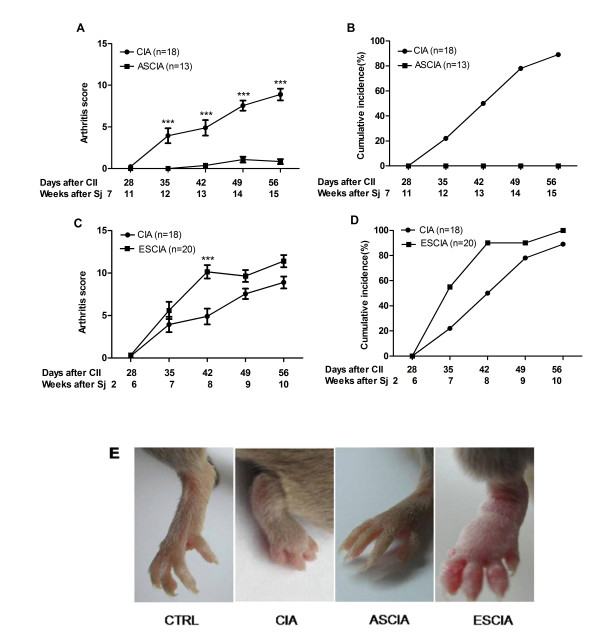
The protective effects against arthritis were only observed when a pre-established Sj infection entered acute stage. DBA/1 mice were infected with Sj for 2 weeks or 7 weeks prior to immunization with collagen II (CII) in CFA and named as ESCIA mice and ASCIA mice respectively. 7 weeks Sj infection significantly reduced the severity (A), incidence (B) and clinical signs (E) of arthritis in ASCIA mice; whereas 2 weeks infection by Sj failed to decrease the severity (C), incidence (D) and clinical signs (E) of arthritis in ESCIA mice. Arthritis was scored weekly as described in Materials and Methods. Circle and square represented uninfected CIA mice and Sj infected CIA mice respectively. CIA data represented the combined results from two different age groups from multiple experiments due to their similar severity and incidence. Data in ESCIA mice were the means and the standard errors of the mean (SEM) of clinical scores from 20 individual mice combined from two separate experiments, while data in ASCIA mice were from 13 individual mice combined from three separate experiments. Significance was tested by two way ANOVA with Bonferroni multiple comparison test with *** as p < 0.001. Incidence was calculated on the ratio of the number of animals with arthritis score >= 3 on one joint over total number of mice.